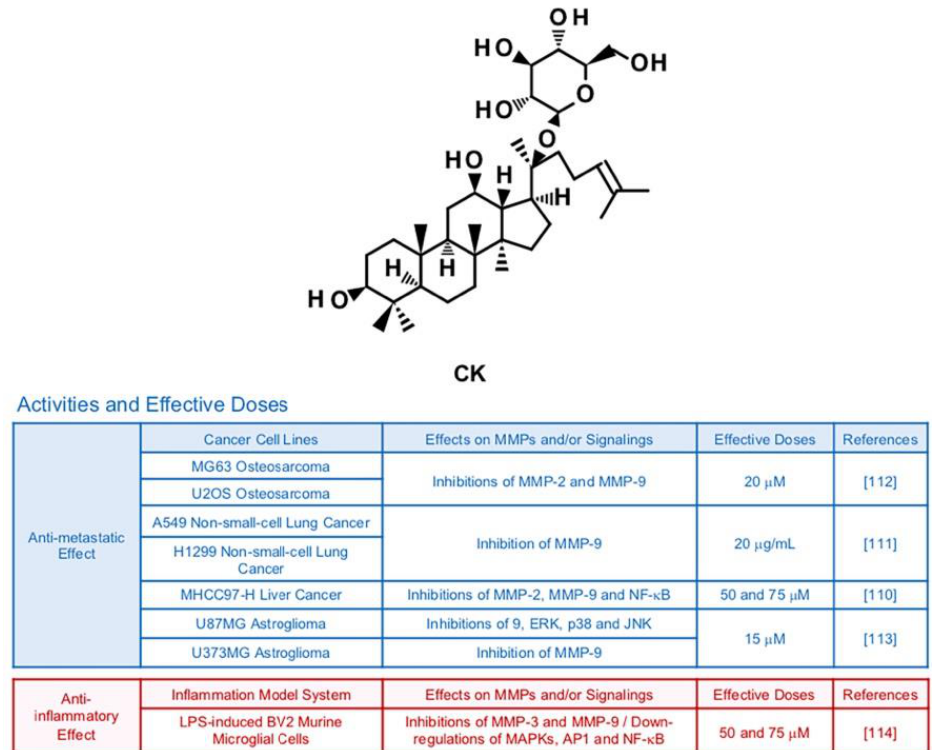
Figure 8. Summary of activities of ginsenoside CK. Structure of CK and its effects on MMPs and/or signalings [110–114].